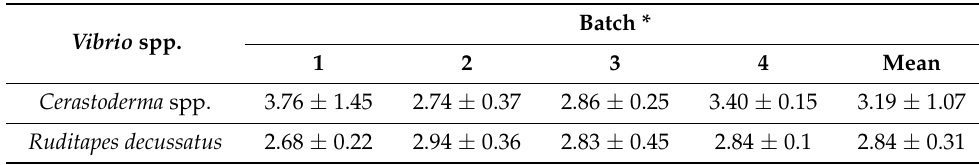
Table 1. Enumeration (mean ± s.d.) of Vibrio spp. (Log 10 cfu/g) in Cerastoderma spp. and Ruditapes decussatus after